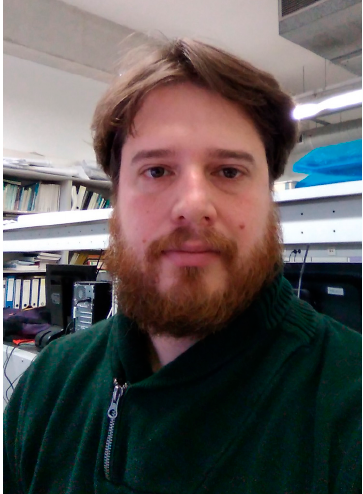
Figure 1. Dr. Joaquim Rovira.